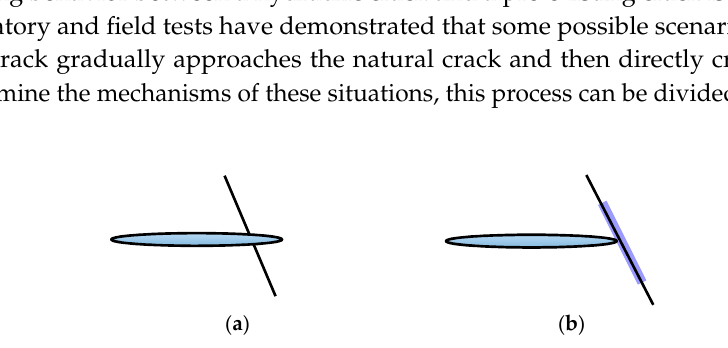
Figure 4. The illustration of crossing between the hydraulic fracture and natural fracture: ( a ) crossing, and ( b ) arrested. The oval represents the hydraulic fracture, the thin, black line represents the natural fracture, and the bold, blue line represents the opening natural fracture.